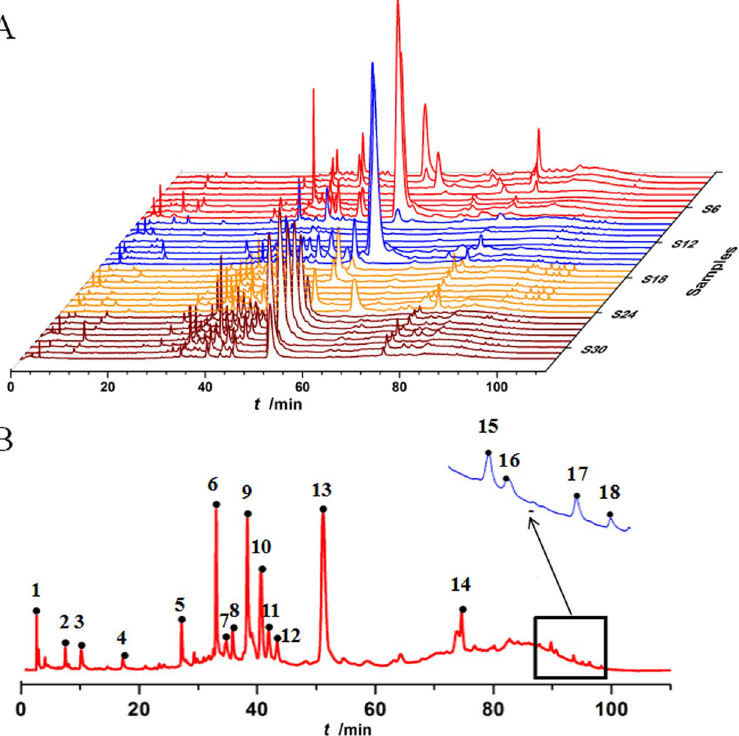
Figure 1. Typical HPLC-DAD fingerprints of 5% methanol extracts of 32 batches of S . Miltiorrhizae from different